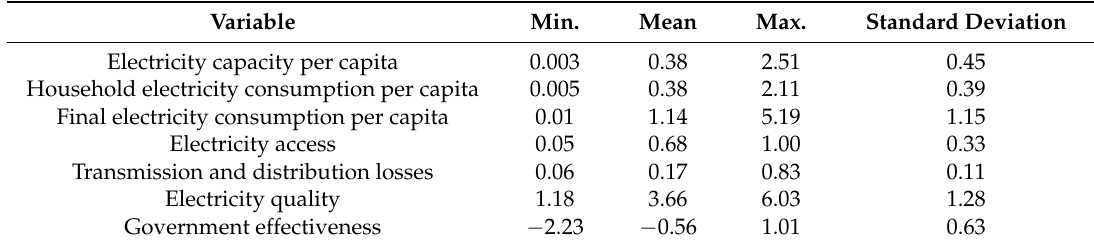
Table 1. Electricity use and government effectiveness, developing countries, 2012. Variable Min. Mean Max. Standard Deviation Electricity capacity per capita 0.003 0.38 2.51 0.45 Household electricity consumption per capita